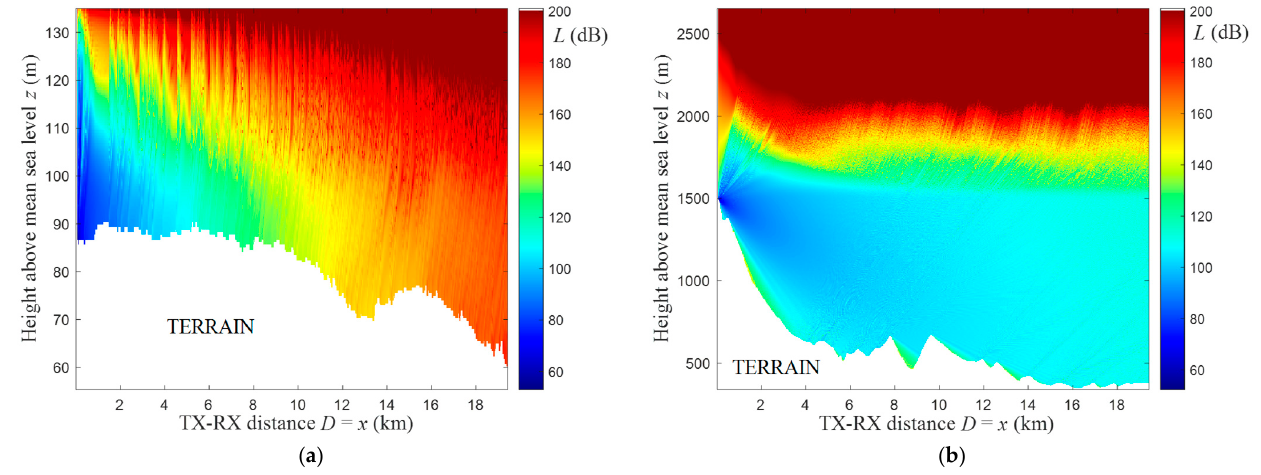
Figure 4. PEM-based electromagnetic field distributions for exemplary terrain profiles from ( a ) low- land and ( b ) hilly